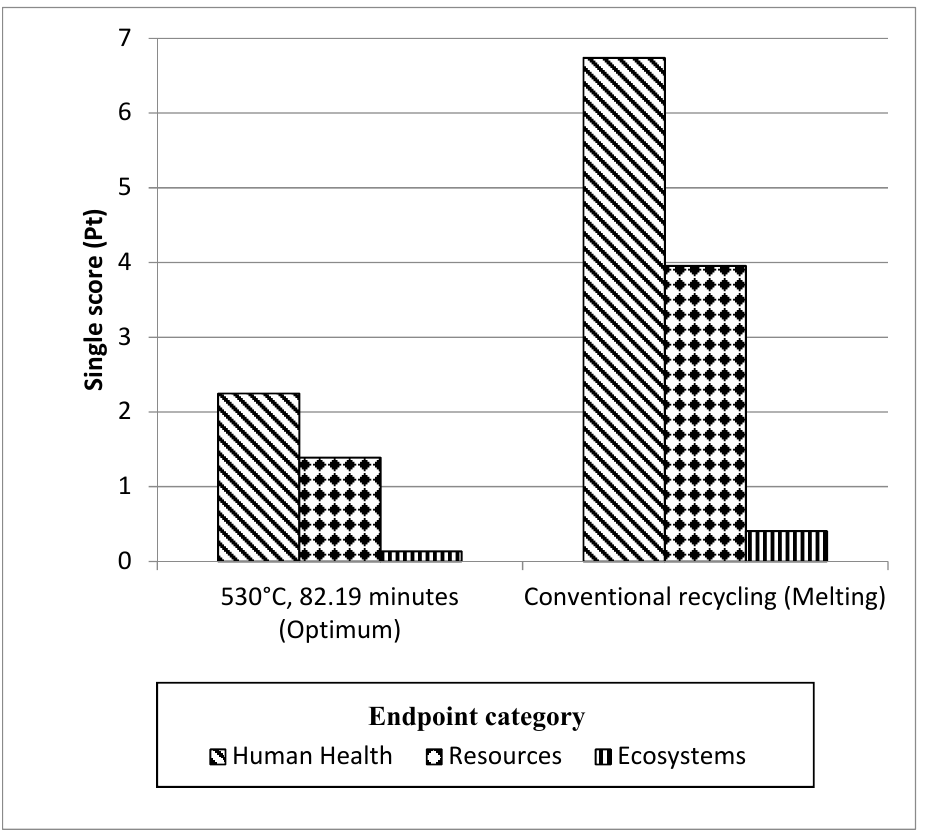
Figure 10. Relative performance endpoints of DR-HPF process and CR of aluminum.